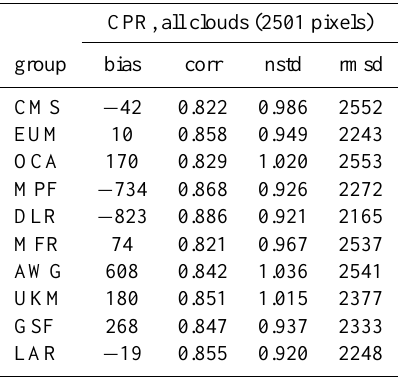
Table 7. Same as Table 6, but for CPR. The mean of CPR observa- tion is 6309m and the standard deviation is